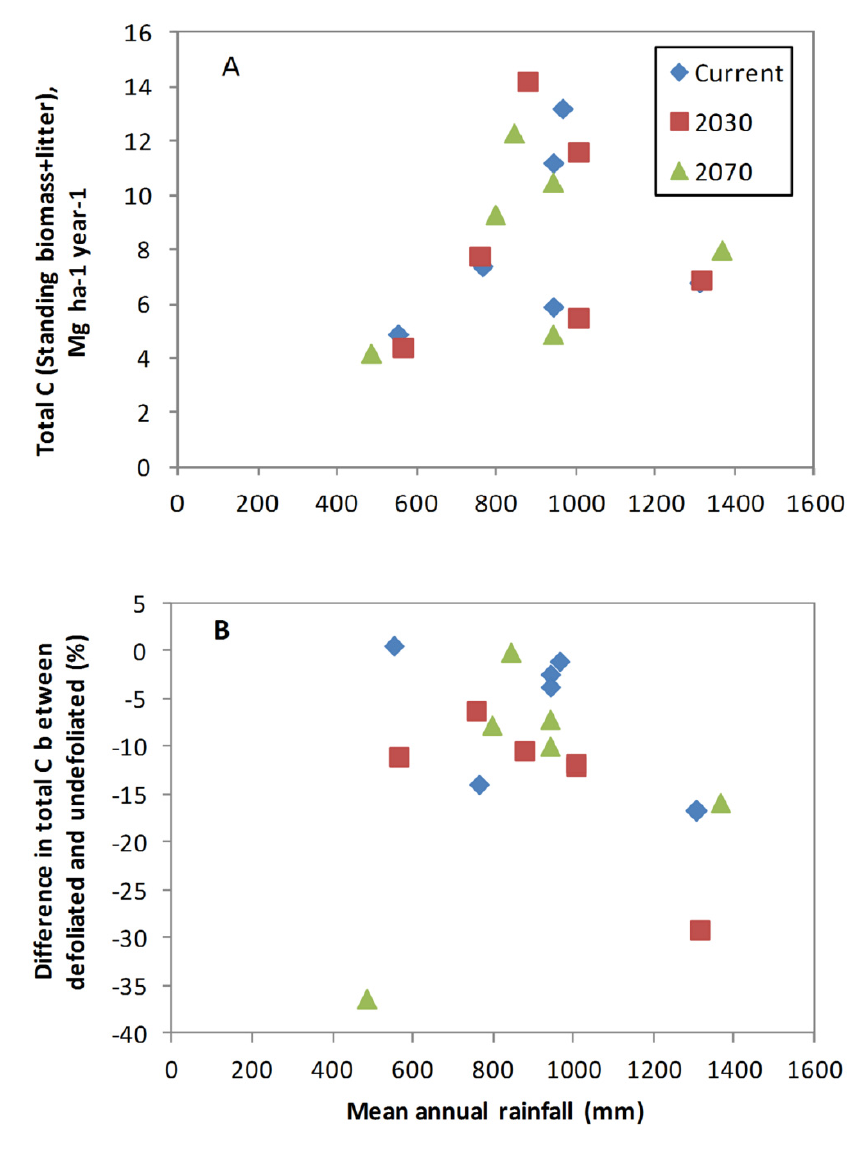
Figure 4. Relationship between ( A ) total C (standing biomass + litter) and rainfall, and ( B ) between the difference in total C between defoliated and undefoliated trees and mean annual rainfall for E. globulus . Estimates were made for current, 2030 and 2070 climate conditions using the CSIRO-Mk3